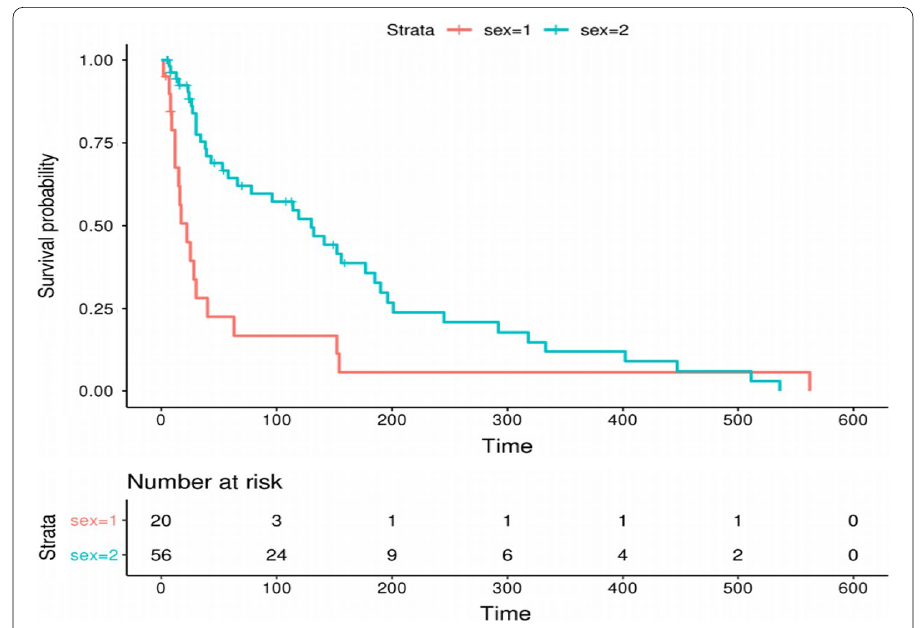
Fig. 8 Survival probability towards sex